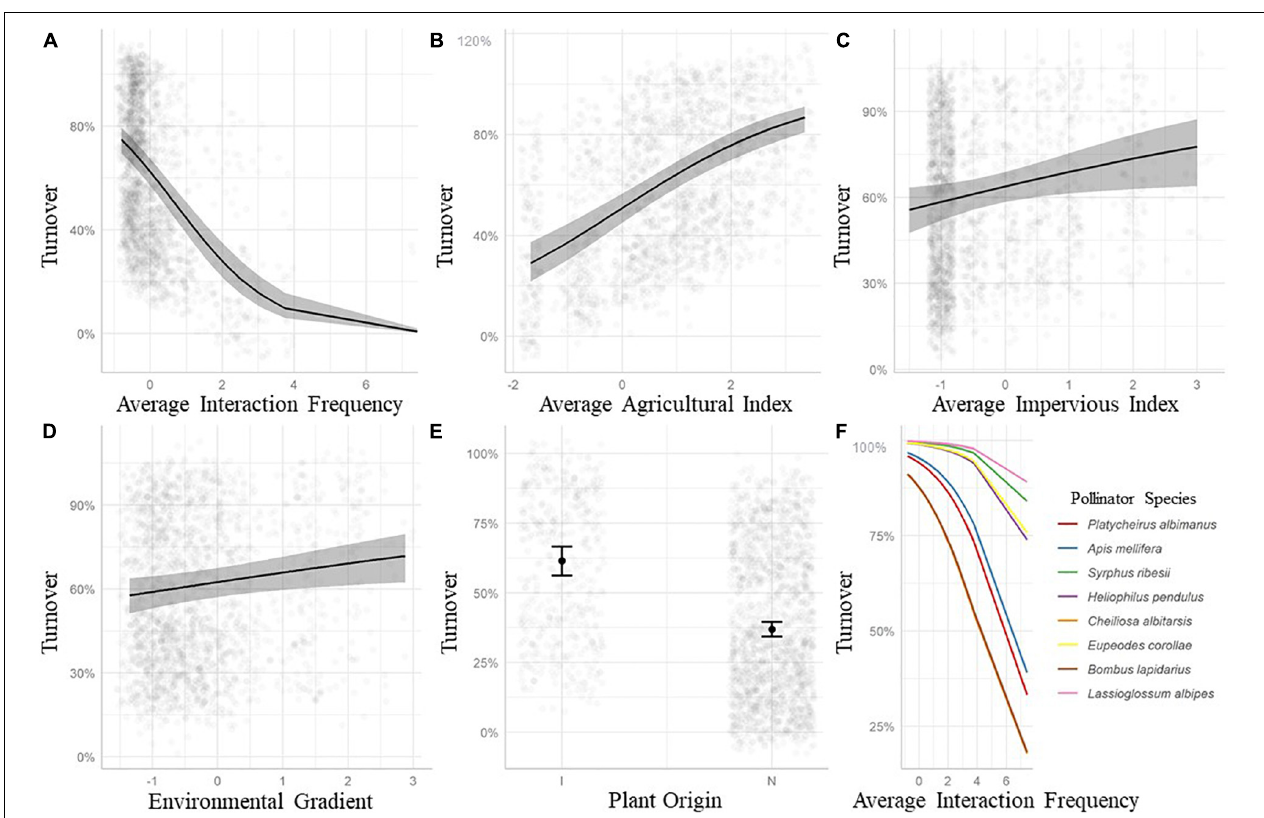
FIGURE 6 | Probability of interaction turnover and model predictors based on a binomial GLM predicting rewiring (A–E) and a sample of individual pollinator responses from a binomial GLMM (F) . (A) Average interaction frequency is negatively related to the probability of interaction turnover. The more frequent interactions show lower probabilities of turnover between sites. (B) The larger the average agricultural index of the site pair, the higher the probability that an interaction turns over. (C) The larger the average impervious index of the site pair, the higher the probability that an interaction turns over. (D) The more dissimilar the environmental gradient is between site pairs, the higher the probability that an interaction turns over. (E) Probability of interaction turnover for native and introduced plant species. (F) Large variance in how the interaction turnover of individual pollinator species changes with average interaction frequency. Superimposed residuals result in darker marks (A–E) . See Supplementary Table S10 for binomial GLM parameter estimates and Supplementary Table S9 for mixed effects GLMM parameter estimates and random effect